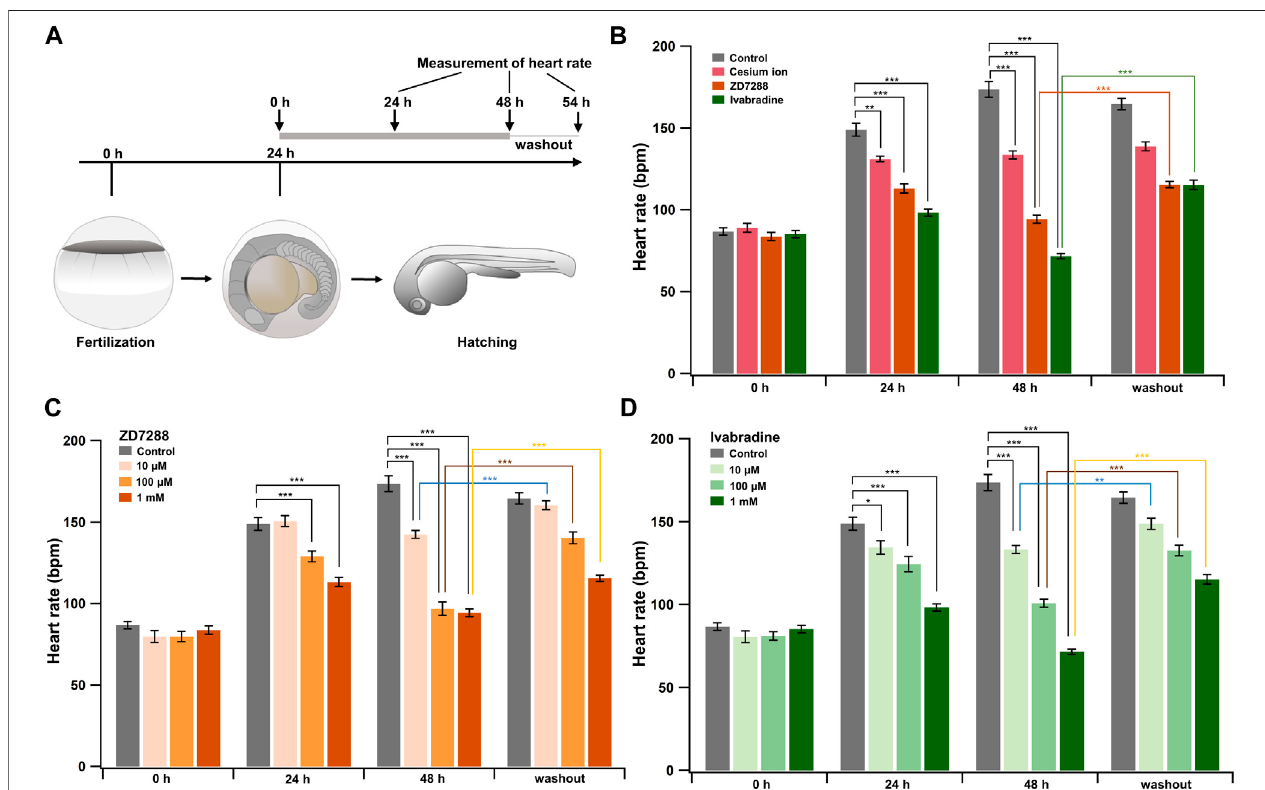
FIGURE 5 | HCN inhibitors reduce heart rate in developing zebra fi sh embryos. (A) Experimental method. Inhibitors were administered in the egg water at 24 hpf, and this time point was designated as “ 0 h ” . After administering the inhibitors, heart rate was measured at 24 h (24 h) and 48 h (48 h). Zebra fi sh were then transferred back totheinhibitor-freeeggwater,andtheirheartratesweremeasured 6 hlater(washout). (B) Changesinheartratewithtimeinzebra fi shbefore(control;grey; n =10) andaftertreatmentwith1 mMcesiumion(pink; n =10),ZD7288(orange; n =10)andivabradine(green; n =10)inhibitors.Heartratesbefore(0 h)andat24 h(24 h) and 48 h (48 h), after application of the inhibitors and at 6 h after washing out the inhibitors (washout) are shown as bar graphs. Dunnett ’ s test was used for statistical analysis,andStudent ’ s t -testwasusedtocomparebeforeandafter “ washout. ” (C) Changesinheartratewithtimeinzebra fi shtreatedwithZD7288before(gray; n =10) and after treatment with 10 μ M (light orange; n = 10), 100 μ M (orange; n = 10), and 1 mM (dark orange; n = 10). Dunnett ’ s test was used for statistical analysis, and Student ’ s t-test was used to compare before and after washout. (D) Changes in heart rate with time in zebra fi sh treated with ivabradine before (gray; n = 10) and after treatmentwith10 μ M(thingreen; n =10),100 μ M(lightgreen; n =10)and1 mM(darkgreen; n =10).Dunnett ’ stestwasusedforstatisticalanalysis,andStudent ’ s t -test was used to compare before and after